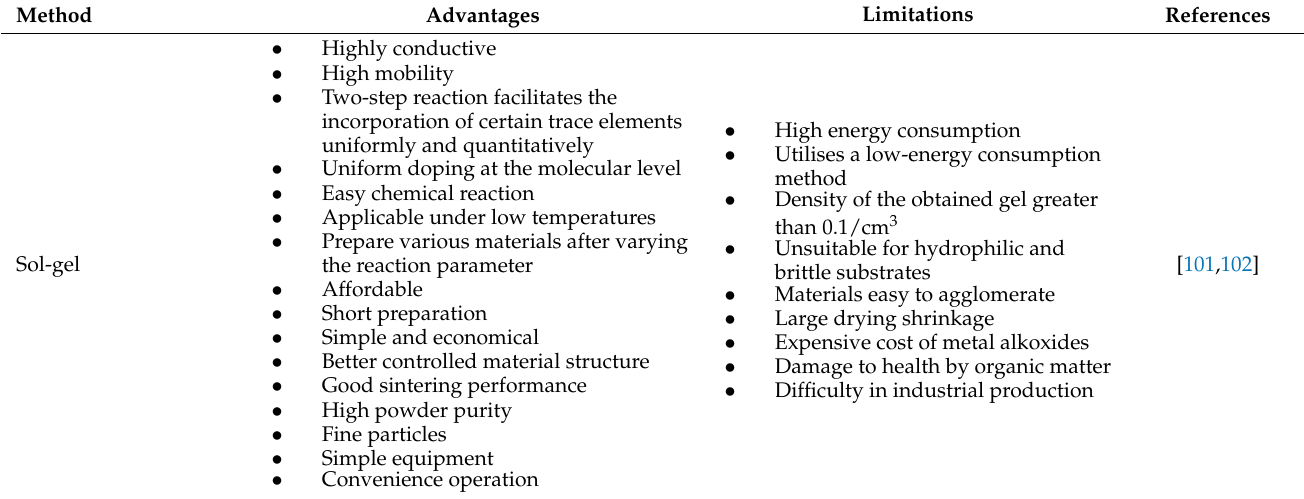
Table 3. The advantages and limitations of NH 3 gas sensor fabrication methods.